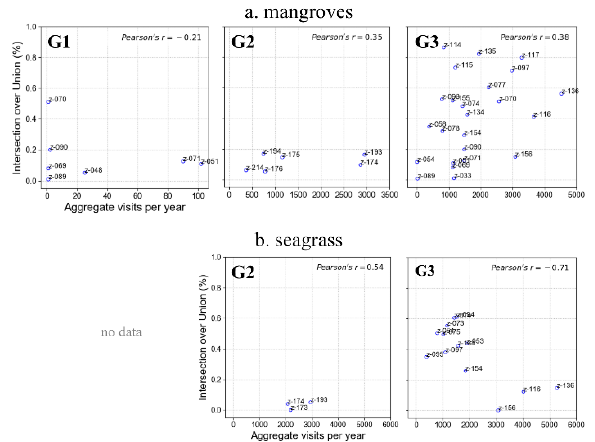
Figure 5. IoU vs. aggregated visits per year V g ( z ) for (a) mangroves and (b) seagrass. Data points for grids with zero- valued IoU and V g ( z ) were not included in the plots.